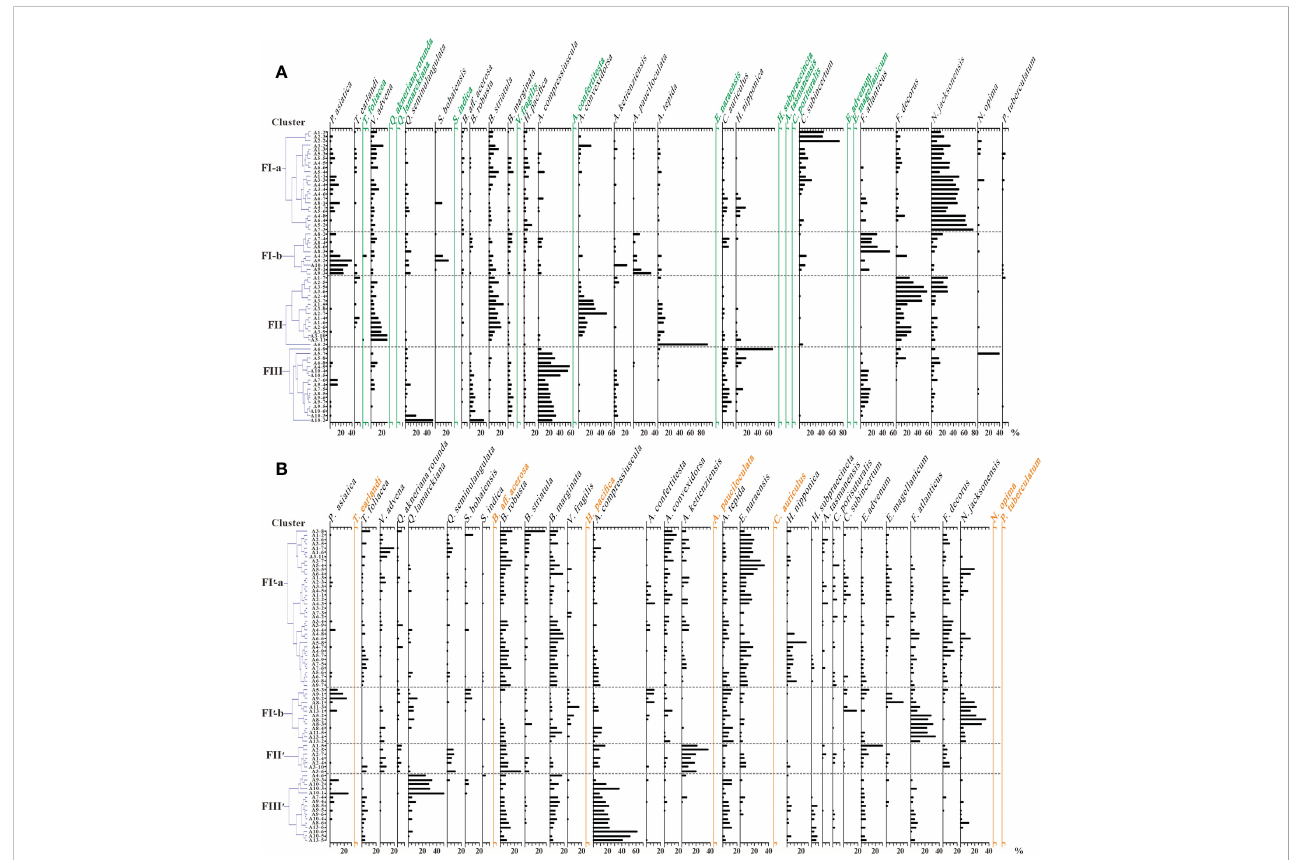
FIGURE 4 Relative abundance (%) of common species of living (A) and dead (B) benthic foraminiferal fauna. Species shown in black are common for both living and dead fauna, and those in green or orange are common only for dead or living fauna. The dendrograms of Q-mode HCA are plotted in the left to show four clusters of common species: FI-a (FI ′ -a), FI-b (FI ′ -b), FII (FII ′ ) and FIII (FIII ′ ) for living and dead fauna in different station groups (see Figure 1B for their locations). Detailed data are included in Supporting Information Table S2-Living BF3 and Dead